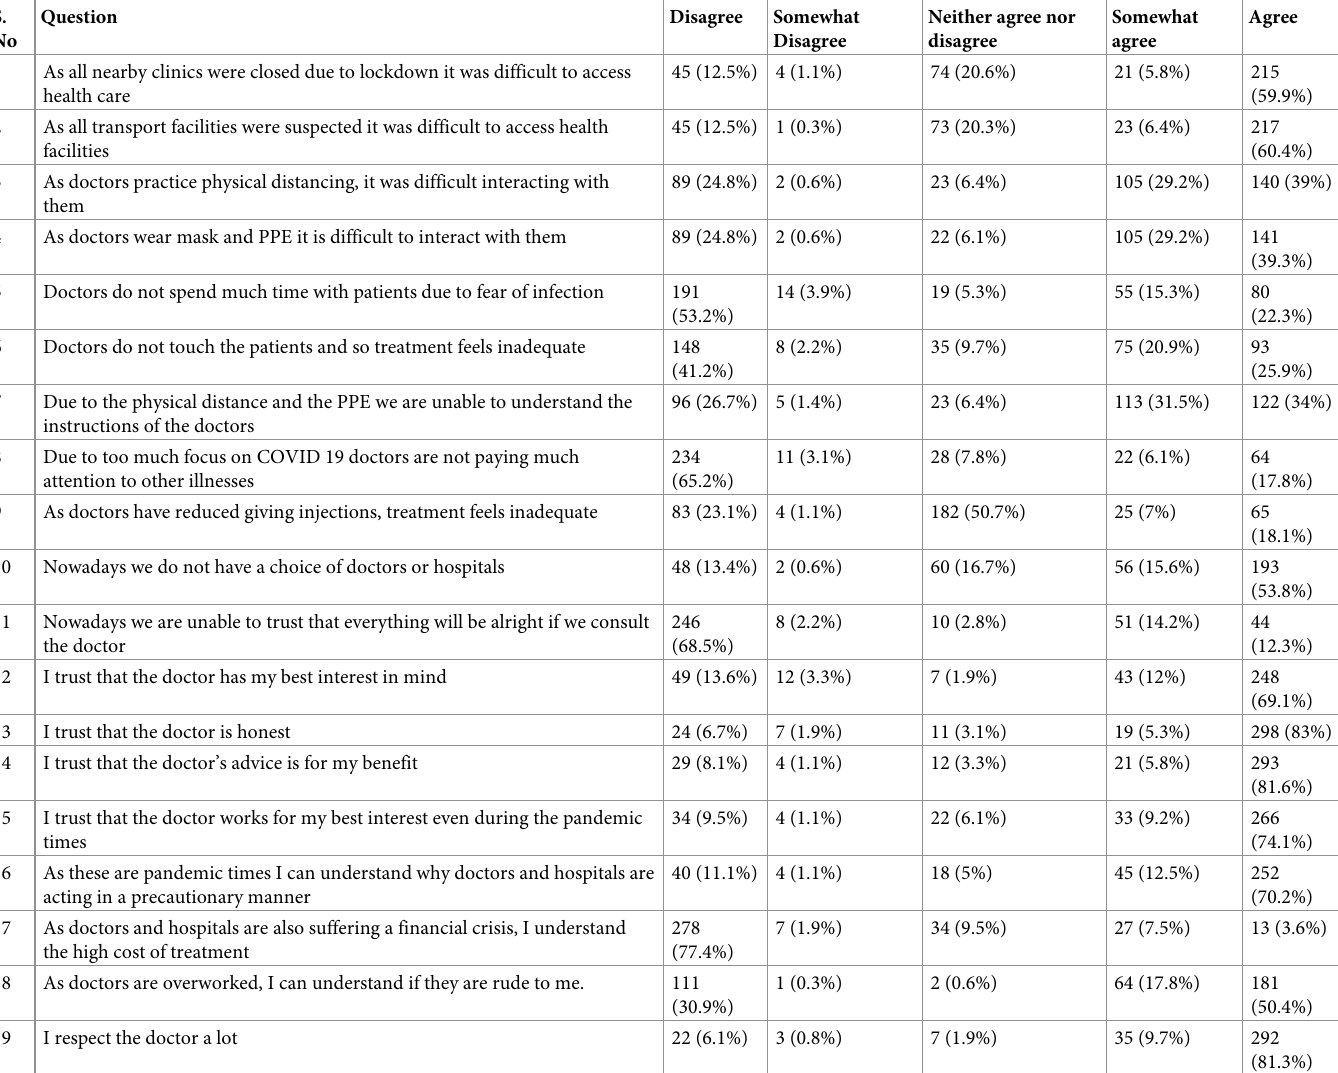
Table 2. Responses to questions related to health care access, doctor-patient communication and trust in doctors during COVID 19 times. S. No